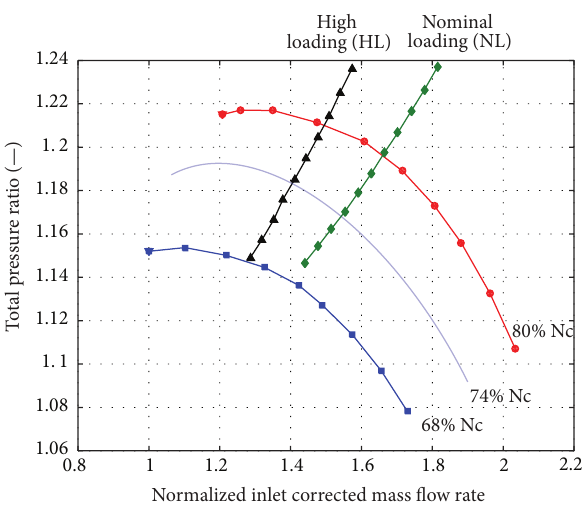
Figure 4: Compressor operating map including operating